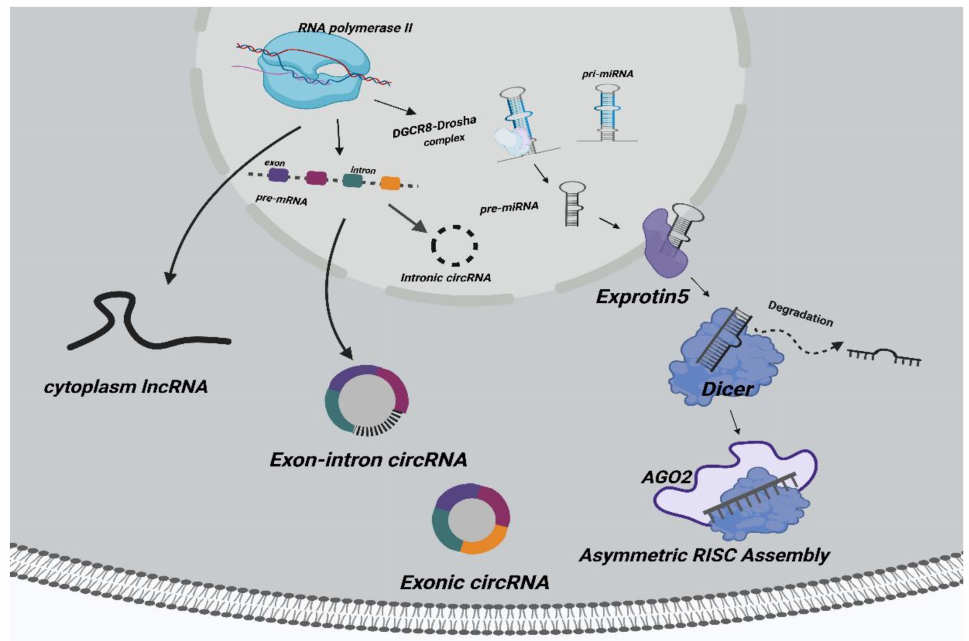
Figure 1. The synthetic pathways of noncoding RNAs. Cytoplasmic lncRNAs are transcribed from its corresponding parent gene. CircRNAs are reverse-spliced from precursor mRNAs and form three types, namely, exon circRNAs, intron circRNAs, and exon–intron circRNAs. MiRNAs are transcribed by RNA polymerase II to generate pre-miRNA and then cut into pre-miRNA through the DGCR8–Drosha enzyme complex. Exprotin 5 transports pre-miRNA out of the nucleus. Dicer and other enzymes cut pre-miRNA into unstable double-stranded RNA outside of the nucleus. One single-stranded miRNA is degraded, and the other is integrated into RISC (ribonuclein complex containing members of AGO